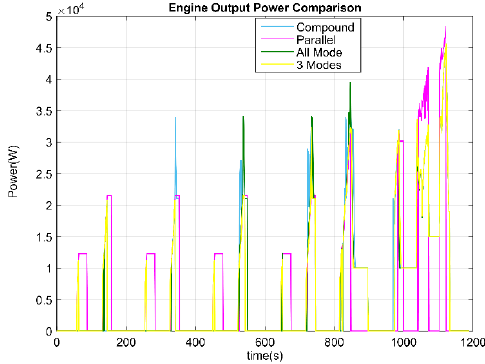
Figure 17. Engine output power for four configurations over the NEDC driving cycle.